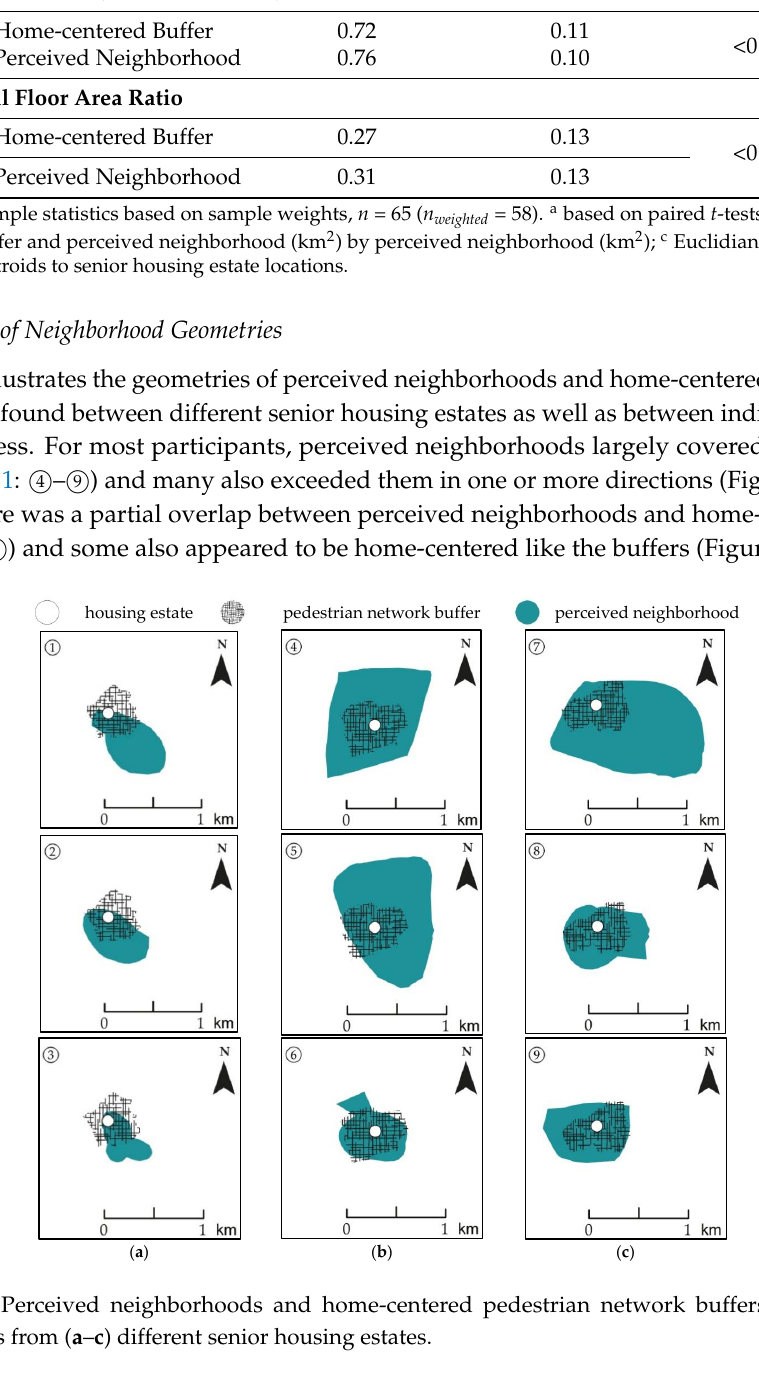
Figure 1. Perceived neighborhoods and home-centered pedestrian network buffers for ( ① – ⑨ ) participants from ( a – c ) different senior housing estates.